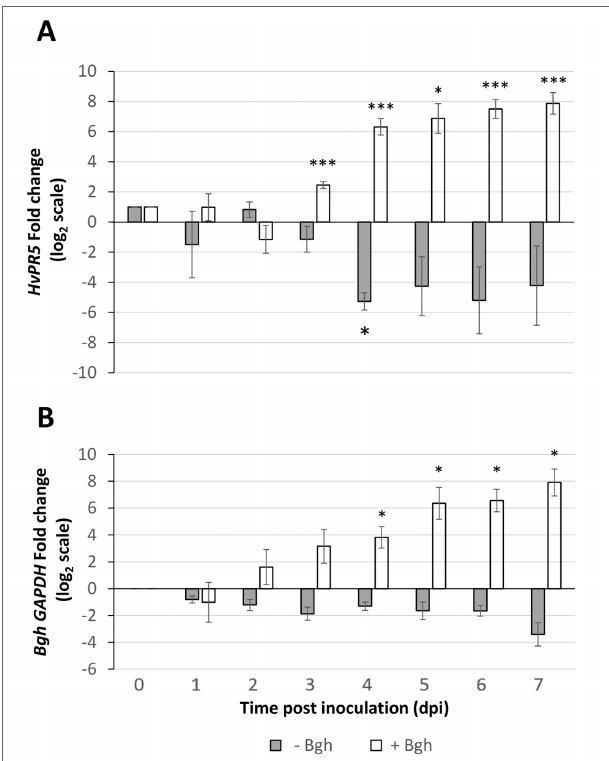
FIGURE 4 | Time course showing relative expression level of (A) , the PR5 isoform thaumatin-like protein 5 ( TLP5 ) (KP293850.1/HORVU5HrG005180.6) and (B) , BghGAPDH (BLGH_00691) in control (grey) and Bgh -infected (white) barley leaves. In control (gray) and Bgh -infected (white) barley leaves. “Zero time point” corresponds to time immediately before inoculation of 7-day- old plants. Relative transcript levels were estimated by qRT-PCR, including HvGAPDH as reference gene. Relative expression levels were normalized to the 0-dpi time point and expressed as log 2 fold change of the reference time point. Each data point shown is the mean ( ± SD) of three independent biological replicates, performed in three technical replicates. Significance was estimated by one-sample t -test. * indicates P < 0.05; *** indicates P < 0.001. qRT-PCR, quantitative reverse transcription polymerase chain